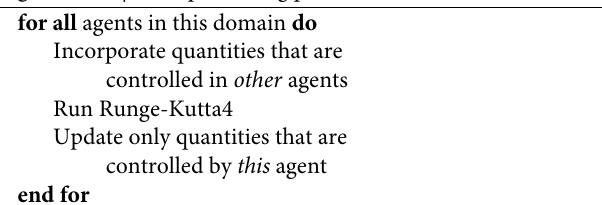
Algorithm 4 | Basic processing pass for the SD models